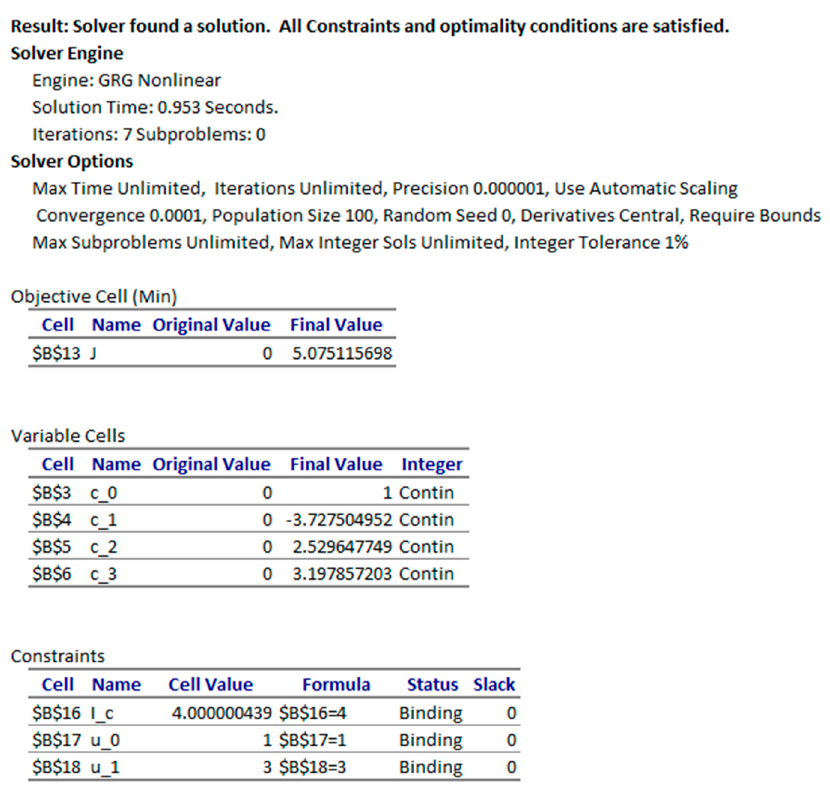
Figure 4. Answer report generated by Excel solver using 3rd order parametrization for problem 3.1.